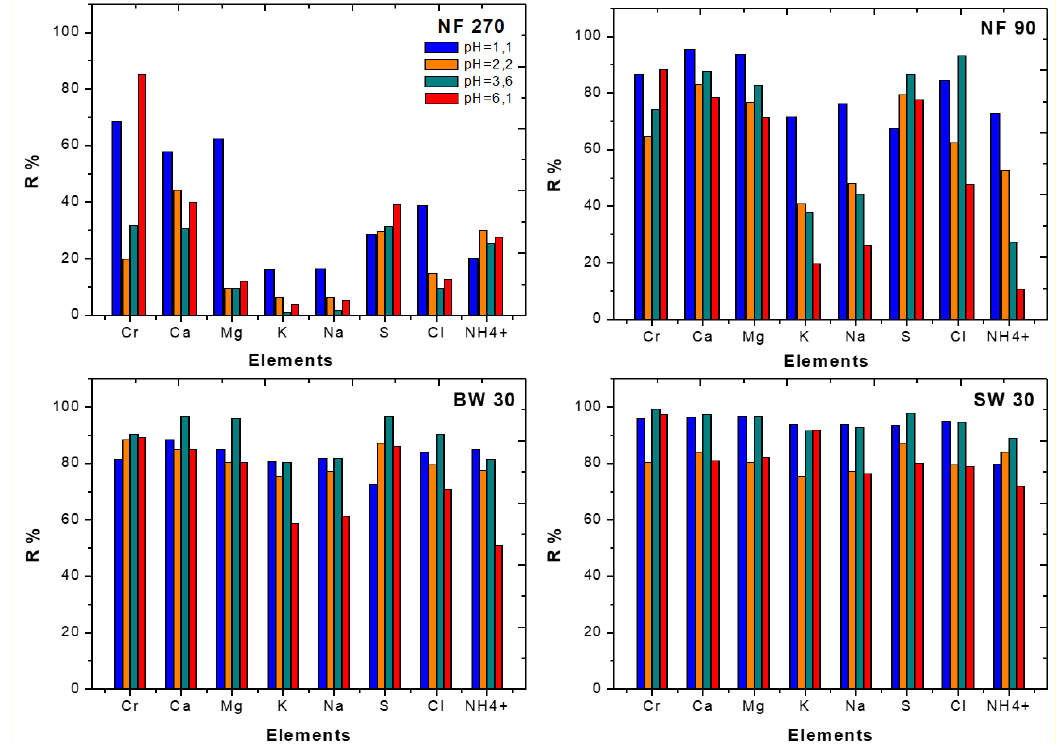
Figure 2. Apparent rejections of the target compounds for the studied RO and NF membranes: NF270 , NF90 , BW30 and SW30 , respectively.